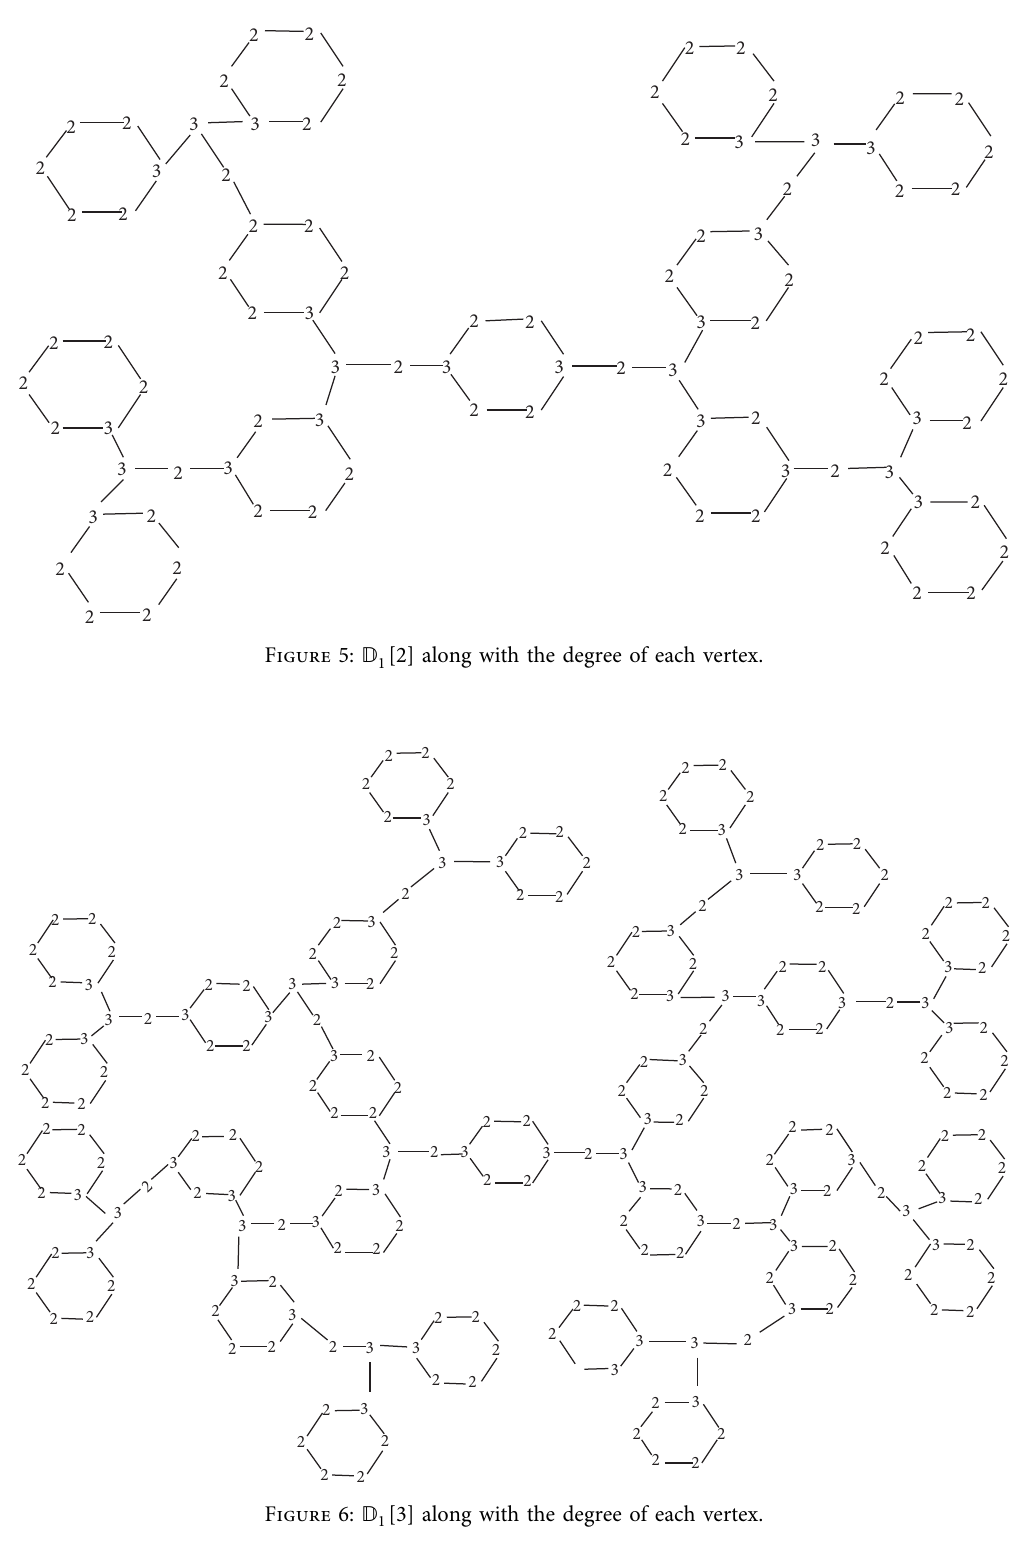
Figure 6: D [ 3 ] along with the degree of each 1